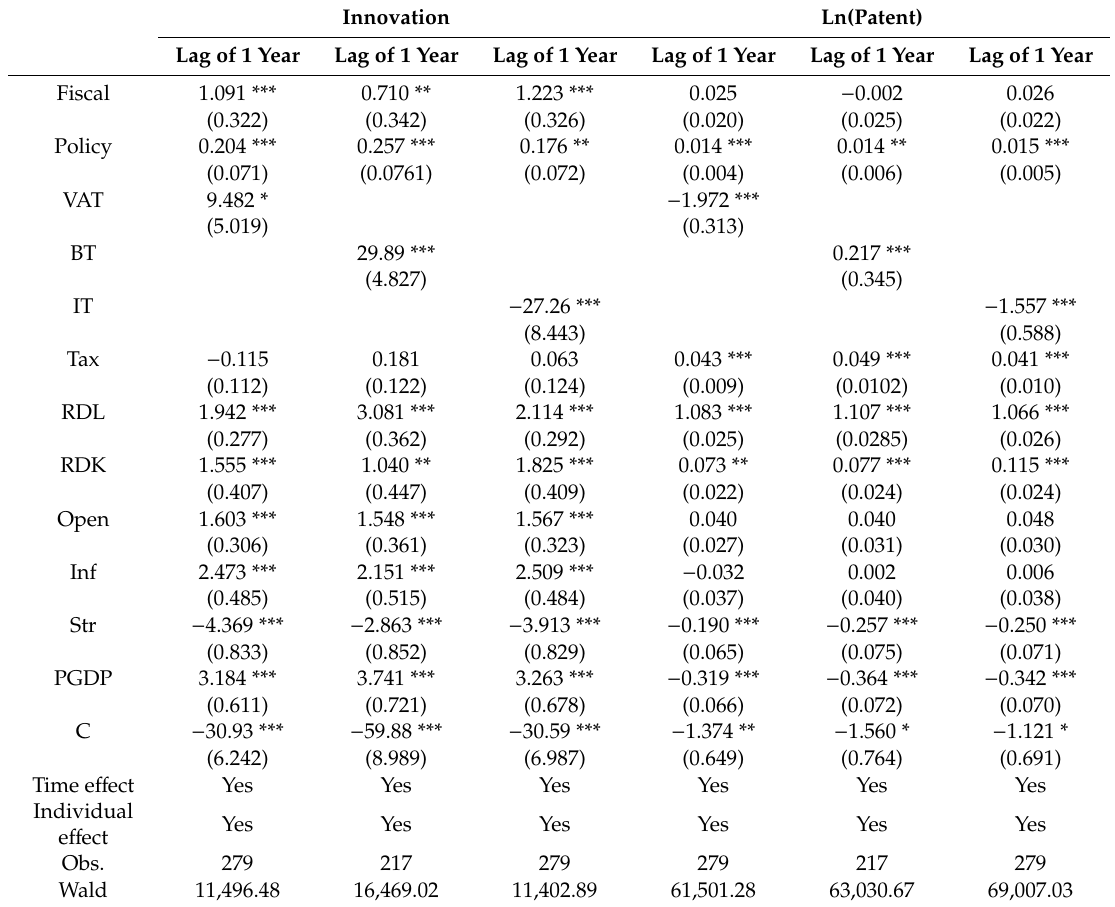
Table 5. Robustness test of